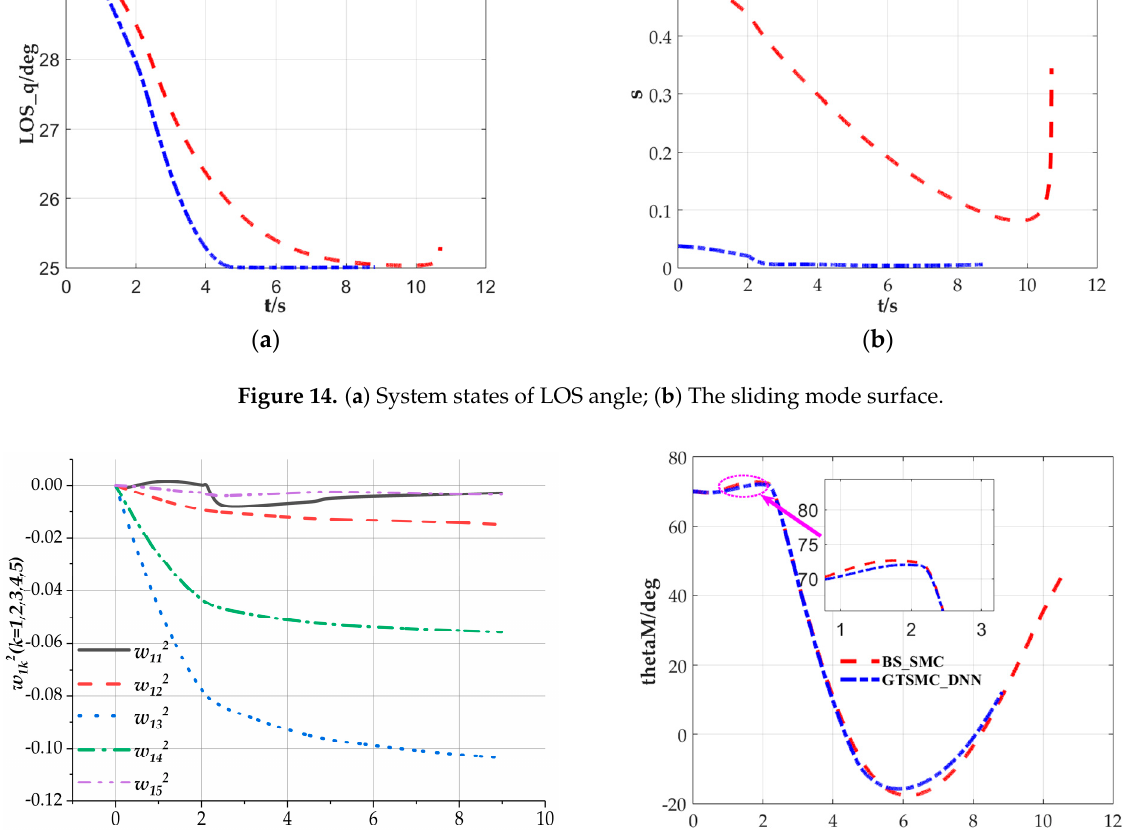
Figure 15. ( a ) The adaptive weight parameters of DNN; ( b ) System states of θ m